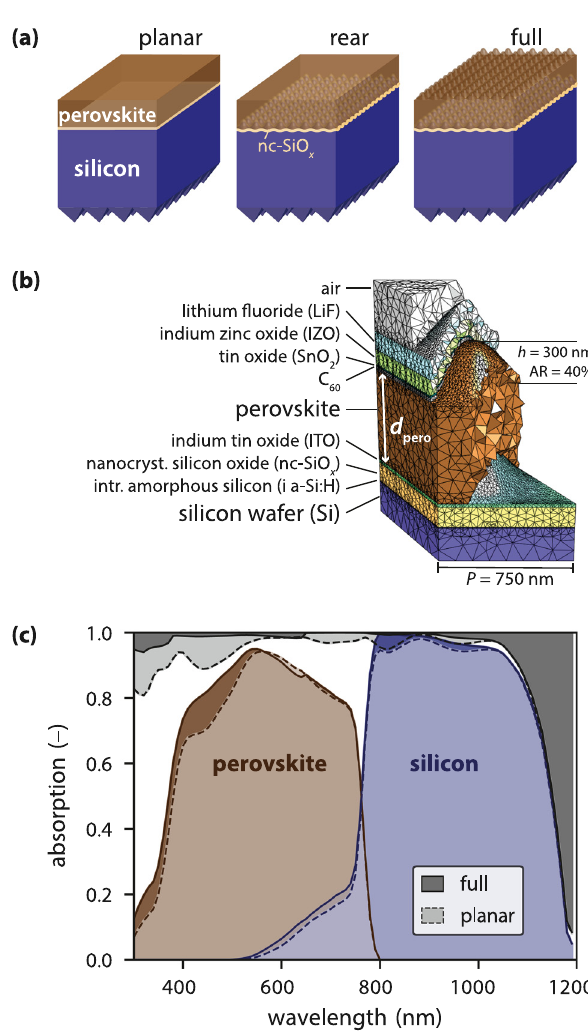
Figure 2: Numerical results on the optical performance of perovskite/silicon tandem cells with either a planar front side, a rear-side textured perovskite cell or a fully textured perovskite cell. Illustrations of the simulated devices are shown in (a), the simulated absorption data for the perovskite and silicon layers of the optimized devices are plotted in (c). The simulations were performed with the finite element method, a typical mesh for a fully-textured device with 750 nm period and 300 nm texture height (equivalent to 40% aspect ratio) is shown in (b). For all devices Lambertian light trapping is considered at the back of the silicon cell. For clarity, the curves for the rear-side textured device are omitted in (c), because they can hardly be distinguished from the curves for the planar device. These results are given in Figure S3 of the Supplementary